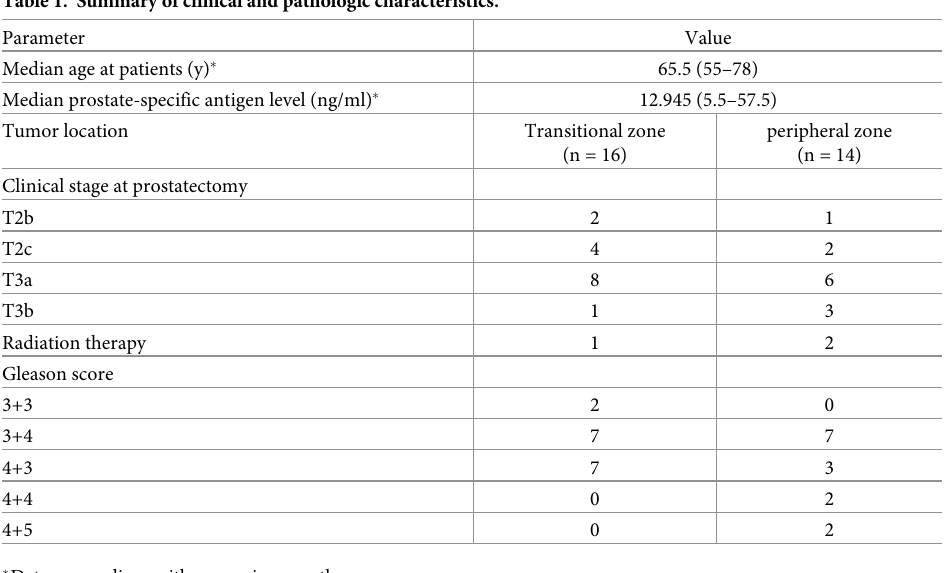
Table 1. Summary of clinical and pathologic